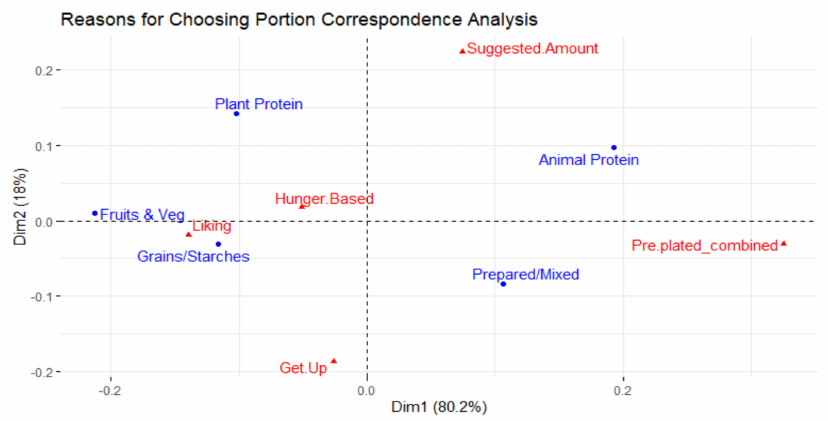
Figure 7. Correspondence analysis relating reasons why participants selected the portion size of the food and the different food